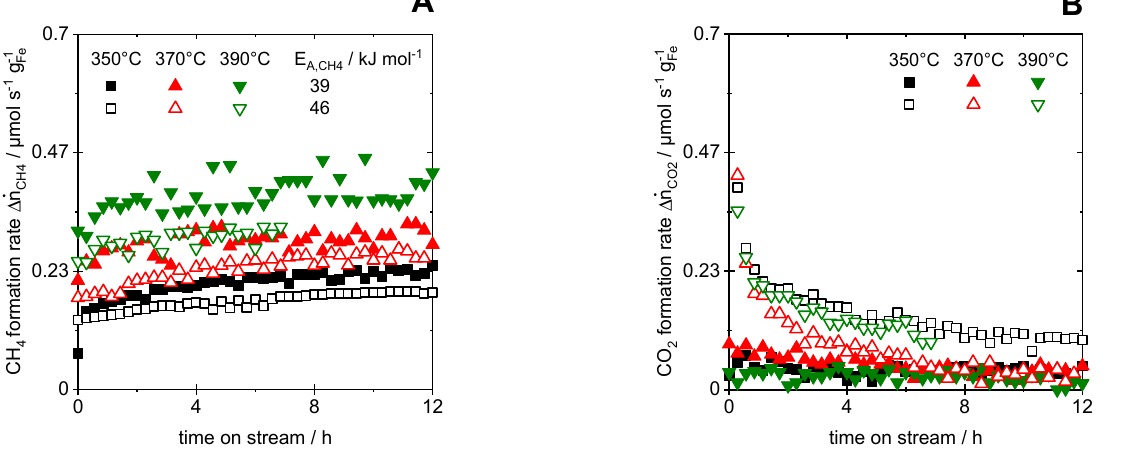
Figure 3. Formation rates ∆(cid:1866)(cid:4662) (cid:3036) as function of time-on-stream for CH 4 ( A ) and CO 2 ( B ) during CO hydrogenation at 350, 370 and 390 ◦ C with Fe@SiO 2 catalyst before (filled symbols) and after (empty symbols) CO 2 treatment; conditions: 200 mg of catalyst, H 2 /CO = 4.5, 1 bar, total volumetric flow rate 100 ml STP /min.